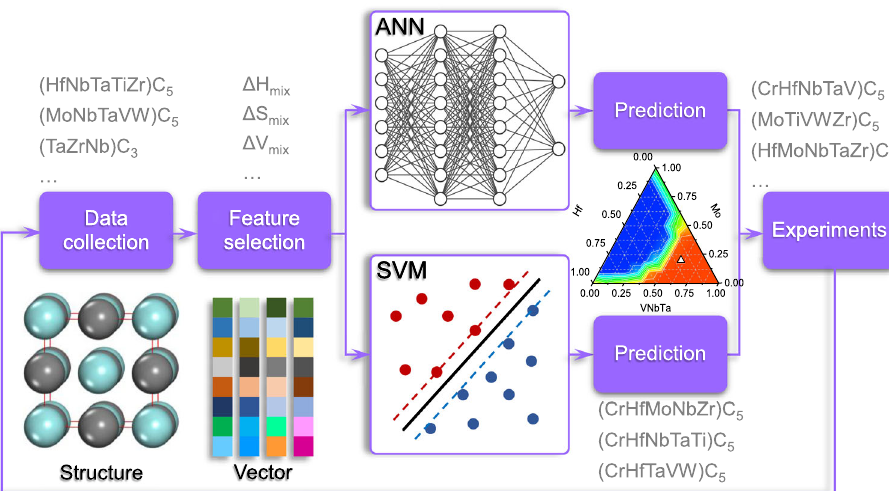
Fig. 10 Machine learning framework. ANN and SVM refer to arti fi cial neural network and support vector machine,